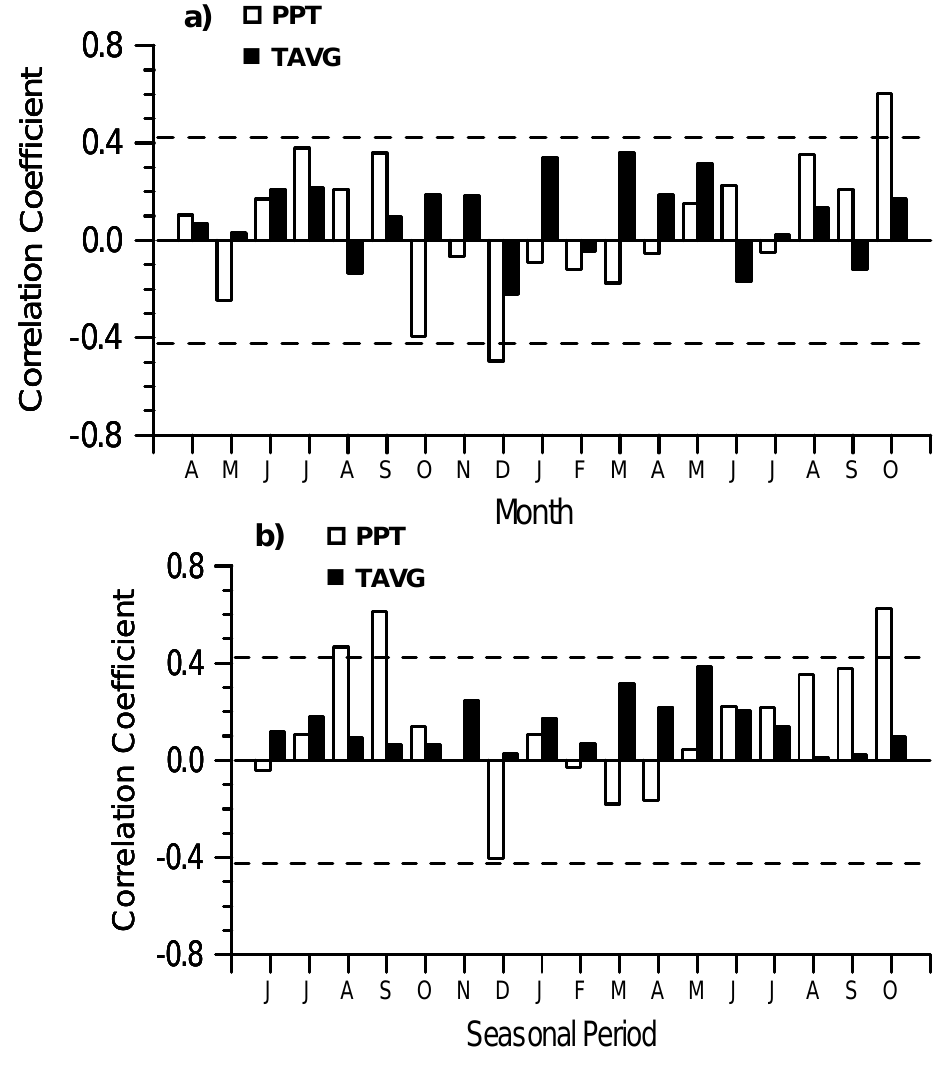
Figure 6. Pearson’s correlation coefficients between the basal area index (BAI) growth chronologies of all 18 full-sib families of hybrid poplar ( P. × smithii ) combined with (a) monthly and (b) seasonal (3 month periods) climate variables: mean temperature (TAVG) and total precipitation (PPT). Broken lines indicate the threshold for significant correlations at P <